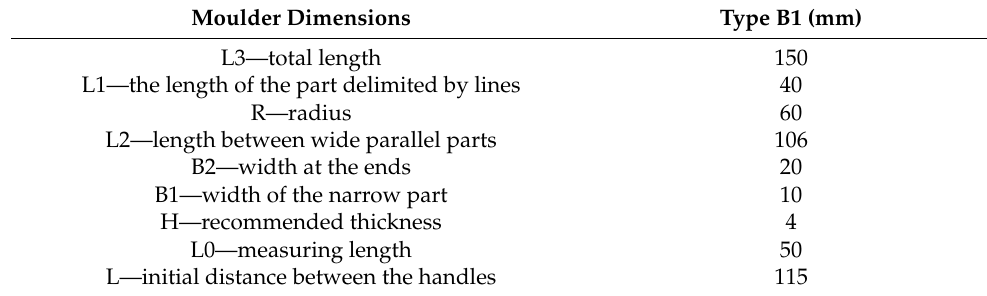
Table 14. Moulder dimensions.